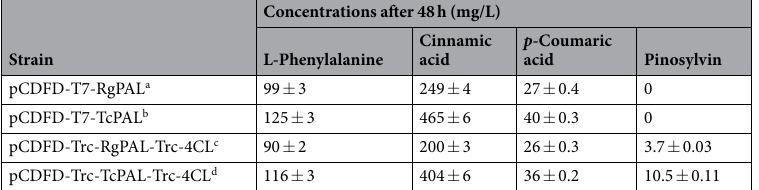
Table 1. Analysis of intracellular pools of pathway intermediates. a RgPAL was directly cloned into Nco I/ Avr II sites of pCDFDuet-1. Engineered strains contained pCOLA-T7-aroF wt -T7-pheA fbr and pCDFD-T7-RgPAL. b TcPAL was directly cloned into Nco I/ Avr II sites of pCDFDuet-1. Engineered strains contained pCOLA-T7- aroF wt -T7-pheA fbr and pCDFD-T7-TcPAL. c Engineered strains contained pCOLA-T7-aroF wt -T7-pheA fbr